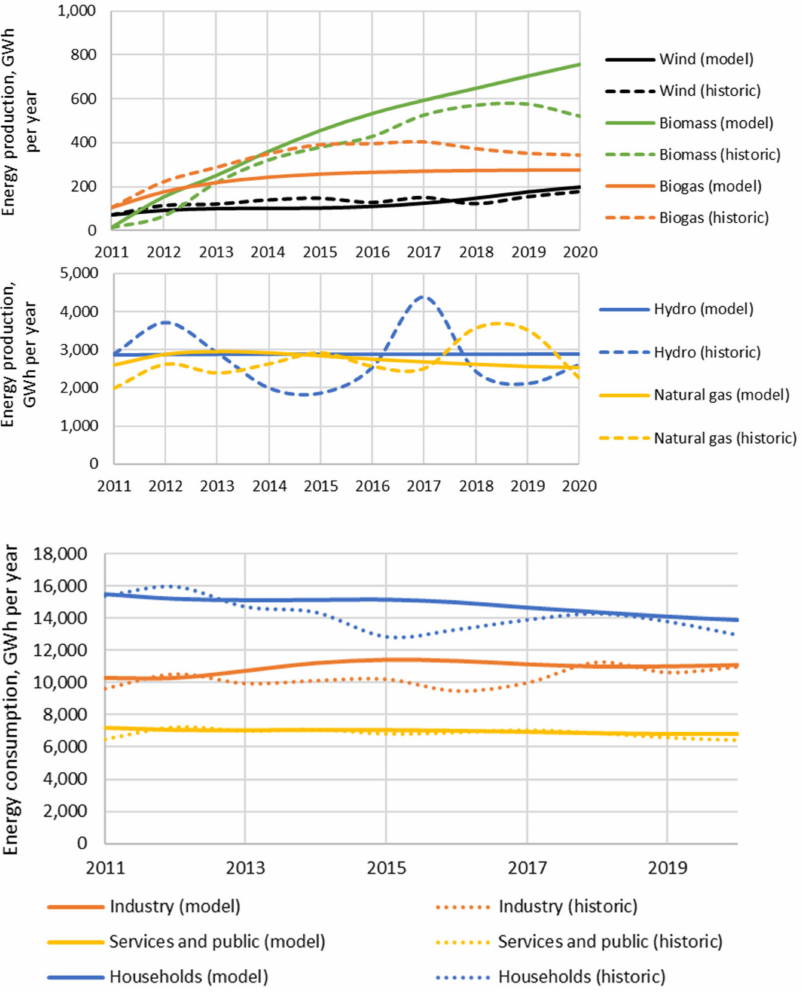
Figure 5. Validation of simulation results with actual data for energy demand and supply